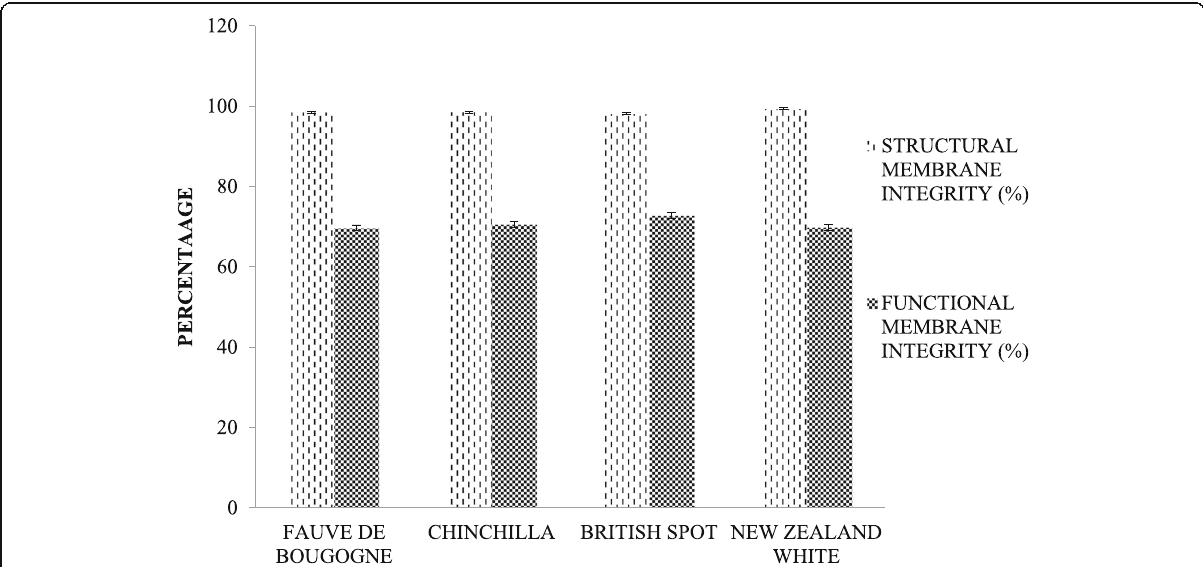
Fig. 1 Structural and functional spermatozoa membrane integrity of four exotic breeds of rabbit buck. Values are means± SEM. Number of ejaculates per breed.30. Level of significance was ( p > 0.05)